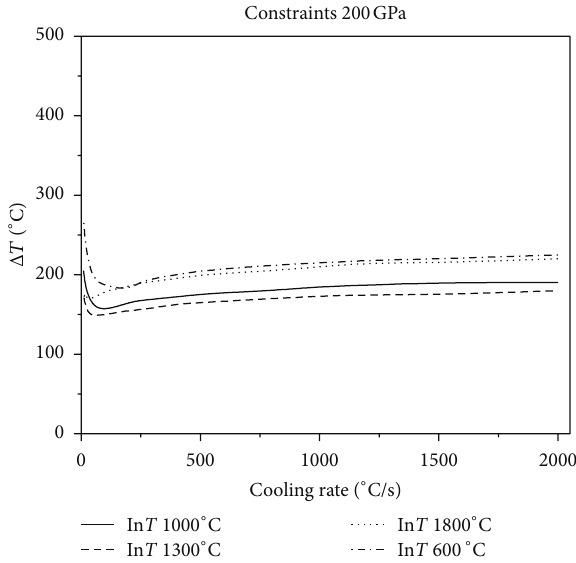
Figure 4: Relationship between critical fracture temperature Δ𝑇 corresponding to different thermal shock initial temperature and cooling rate which Young’s modulus of constraint material is 200 GPa.